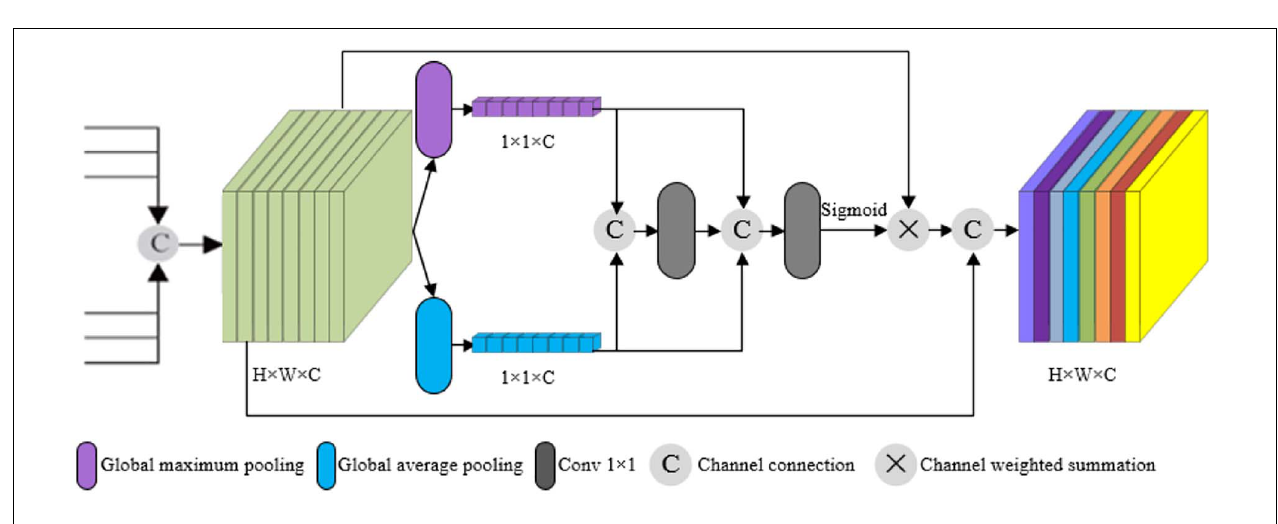
FIGURE 2 | Efficient channel attention